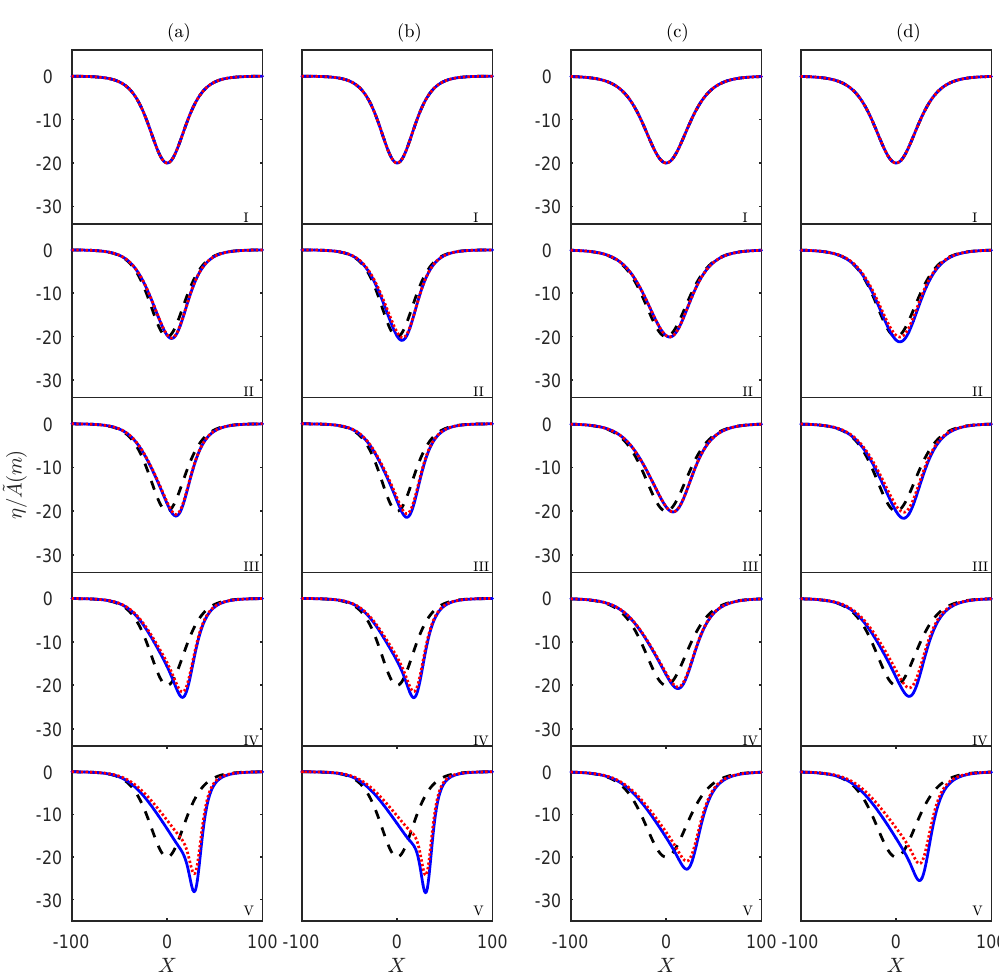
Figure 7. A numerical simulation of the vKdV Equation (5) for the South China Sea case for summer ( a , b ) and winter ( c , d ) conditions, with u 0 = 0 ( a , c ) or u 0 (cid:54) = 0 ( b , d ), respectively. The initial condition is the solitary wave (black, dash), the numerical solution is ˜ A (red, dot) and the physical solution is η (blue, solid). From top to bottom, the distances from the initial point are (I) 0 km, (II) 110 km, (III) 220 km, (IV) 330 km, (V) 440 km,